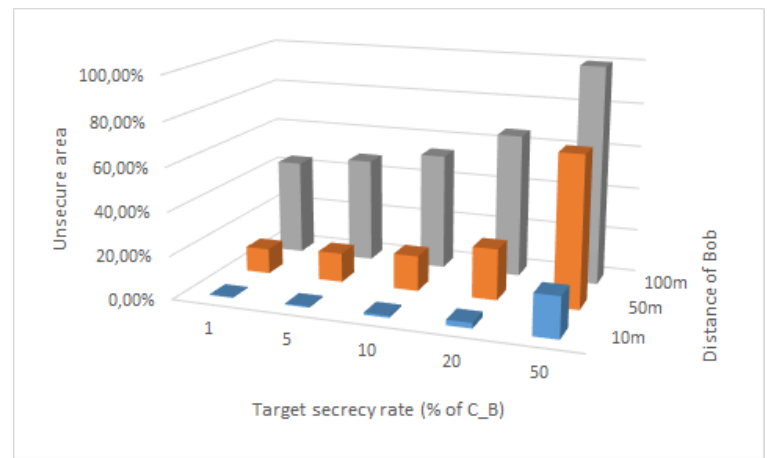
Figure 8. Percentage of unsecure area (over the total coverage) as a function of the distance of Bob and the target secrecy rate to be supported. The transmit power is P = 20 W, which corresponds to a consumed power P in = 291.22